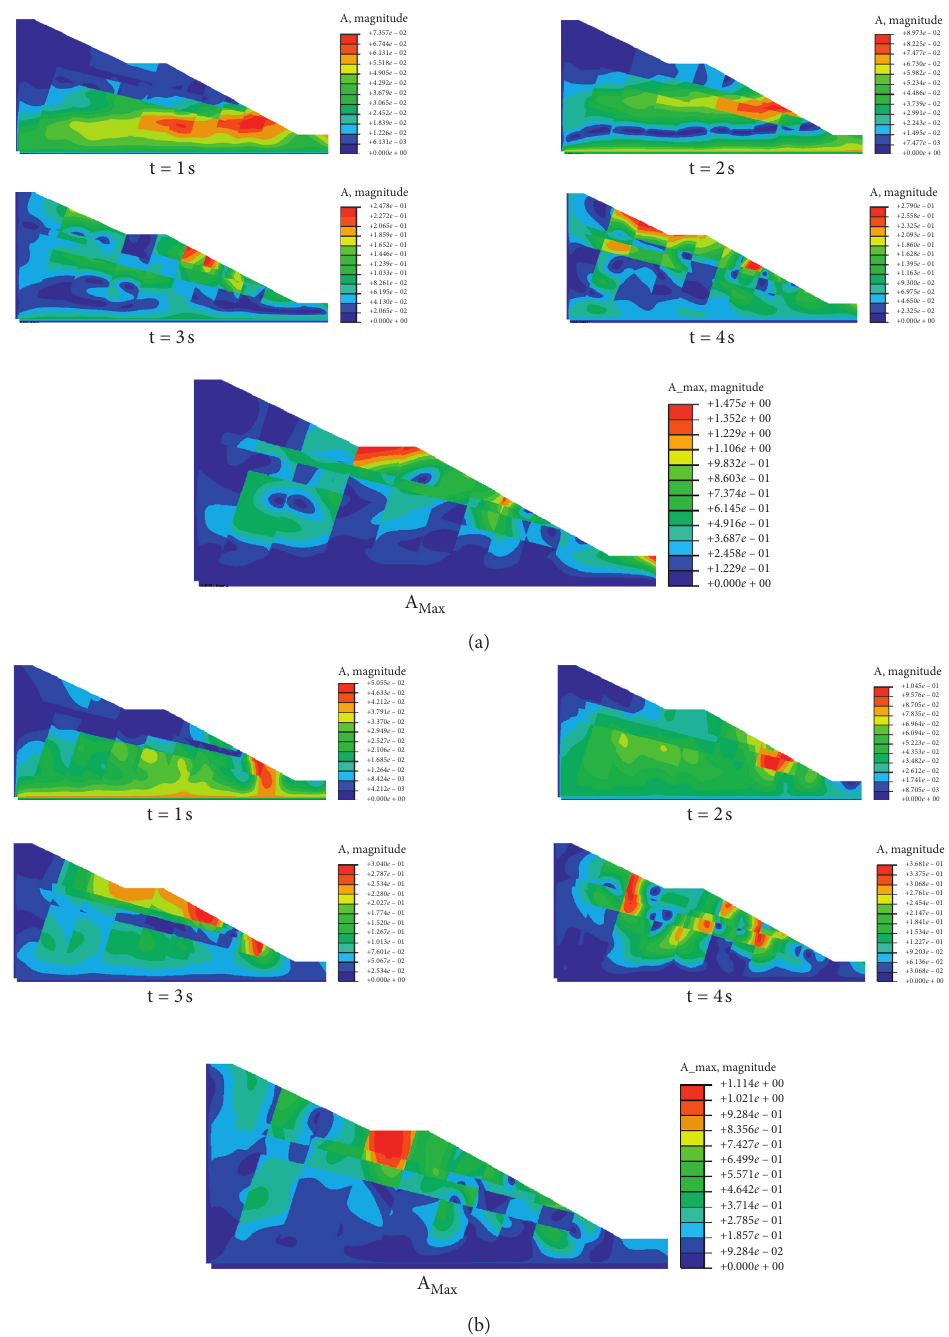
Figure 7: Acceleration response of Lijiang slope: (a) input in x direction; (b) input in z